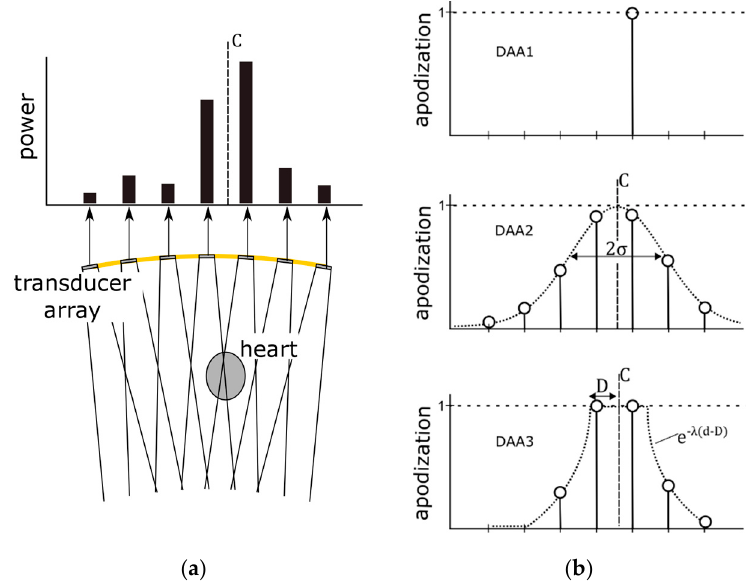
Figure 4. Illustration of the working principle of the dynamic apodization adaptation: ( a ) Received Doppler power measured in the individual transducer elements of the flexible transducer array. ( b ) For the DAA1-method, the apodization of a single element, which received the highest Doppler power, is set to 1. For the window-based apodization methods DAA2 and DAA3, the power center C defines the center of the window-based methods and the apodization of the elements is set accordingly.